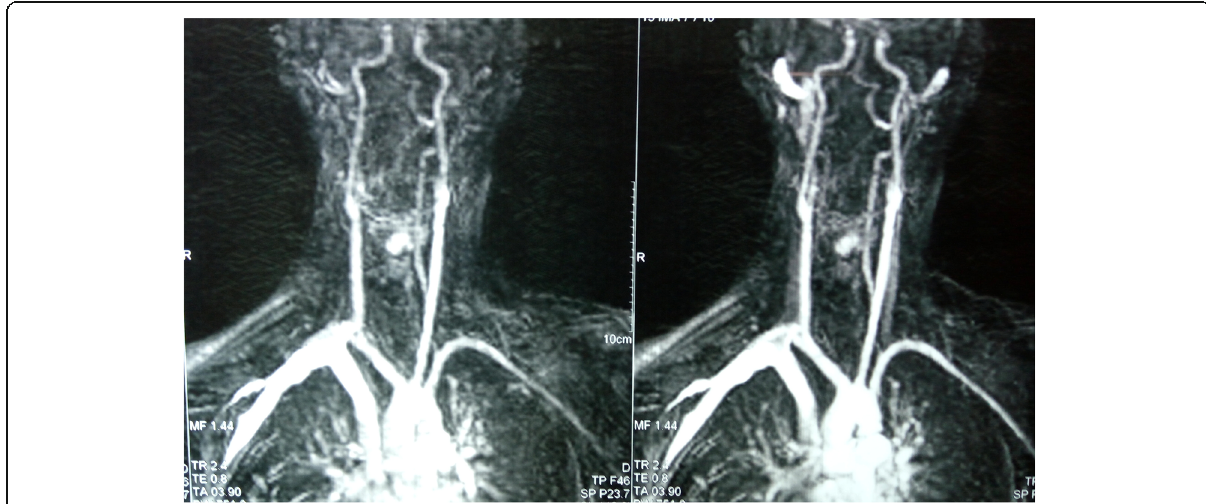
Fig. 3 MR angiography showing dominant feeders from the superior thyroid artery